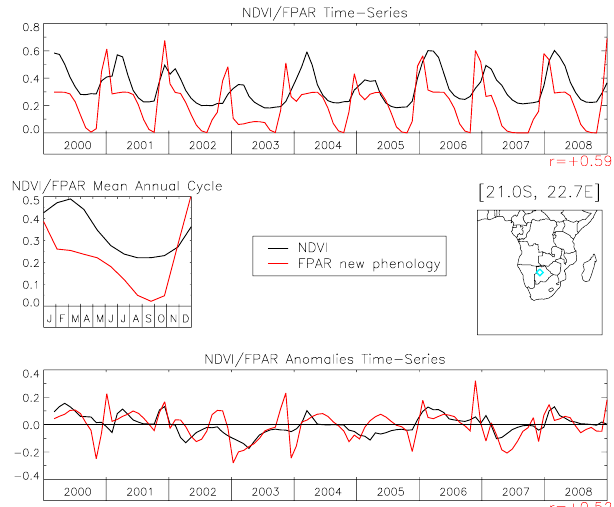
Fig. 1. Top plot: Monthly time series of the NDVI (black thick curve) and the FPAR (red thick curve) over the MODIS period, for a model box located in Bostwana (21.0 ◦ S, 22.7 ◦ E, see cyan diamond on the map). The correlation coefficient of the two time series is given on the right under the top plot ( r = 0.59). Using the nine years between 2000–2008, a mean annual cycle for both the NDVI and FPAR signals is derived (middle left plot). We then subtract each year these mean annual cycles from their respective time series and get NDVI and FPAR anomaly time series (bottom plot). The correlation coefficient of the two anomaly time series is given on the right under the bottom plot ( r =